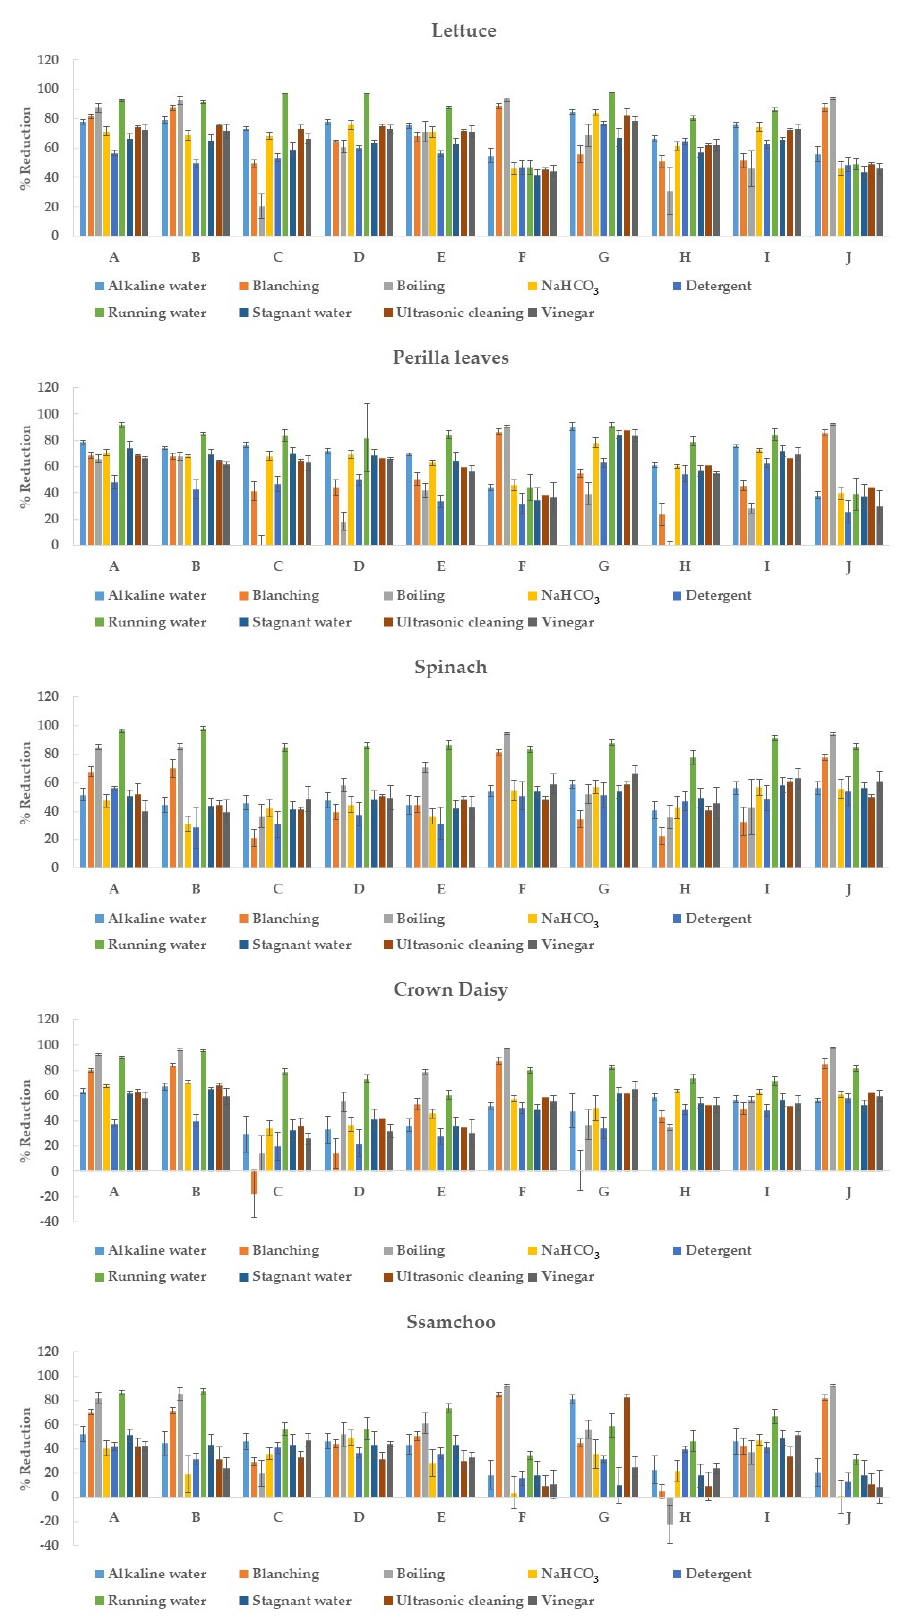
Figure 2. Comparison of removal efficiency of each pesticide in five leafy vegetables (n = 5). A: azoxystrobin, B: chlorantraniliprole, C: chlorfenapyr, D: diniconazole, E: fludioxonil, F: imidacloprid, G: indoxacarb, H: lufenuron, I: pyraclostrobin, and J: thiamethoxam.